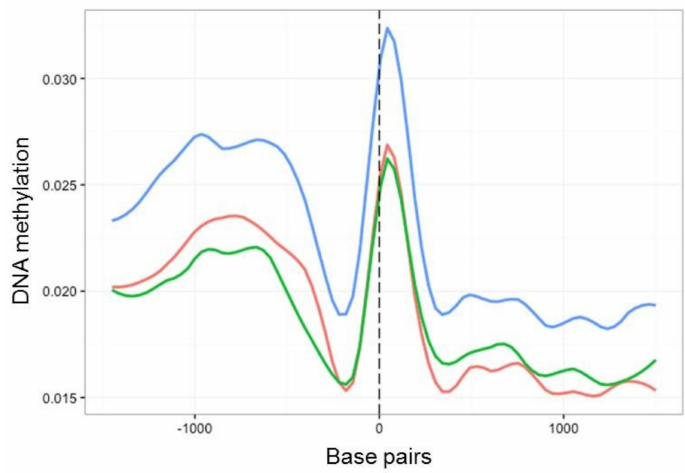
Figure 4. Methylation density across transcription start site (TSS) regions of all B. cinerea selected genes. Methylation level (vertical axis) at each time point (T1, red; T8, green; T8P, blue) was identified as the proportion of methylated cytosines against all cytosines in 30 bp windows 1.5 kb before and after the transcription start site.